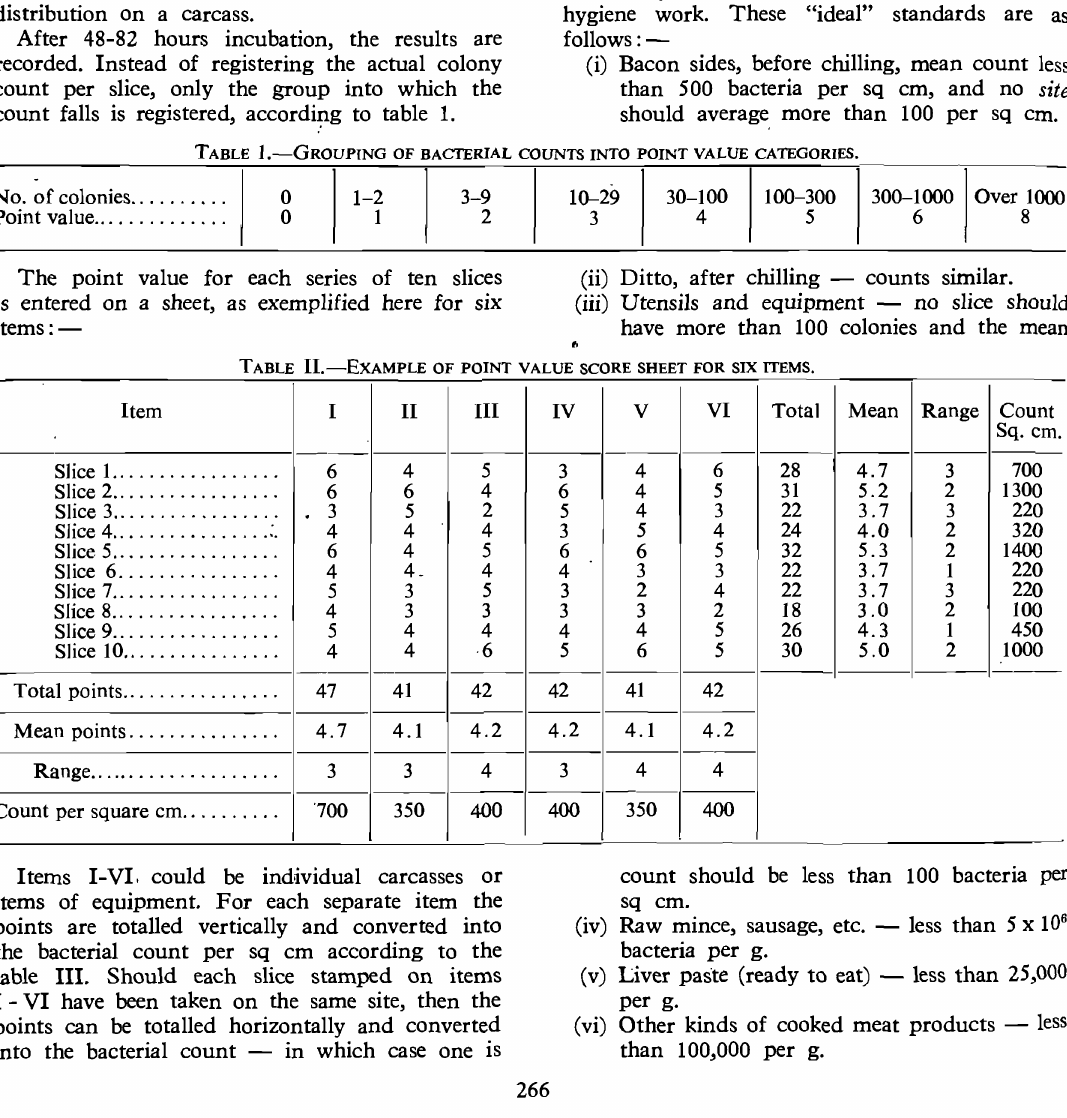
TABLE I.-GROUPING OF BACTERIAL COUNTS INTO POINT VALUE CATEGORIES.